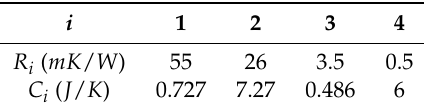
Table 5. The Initial Model